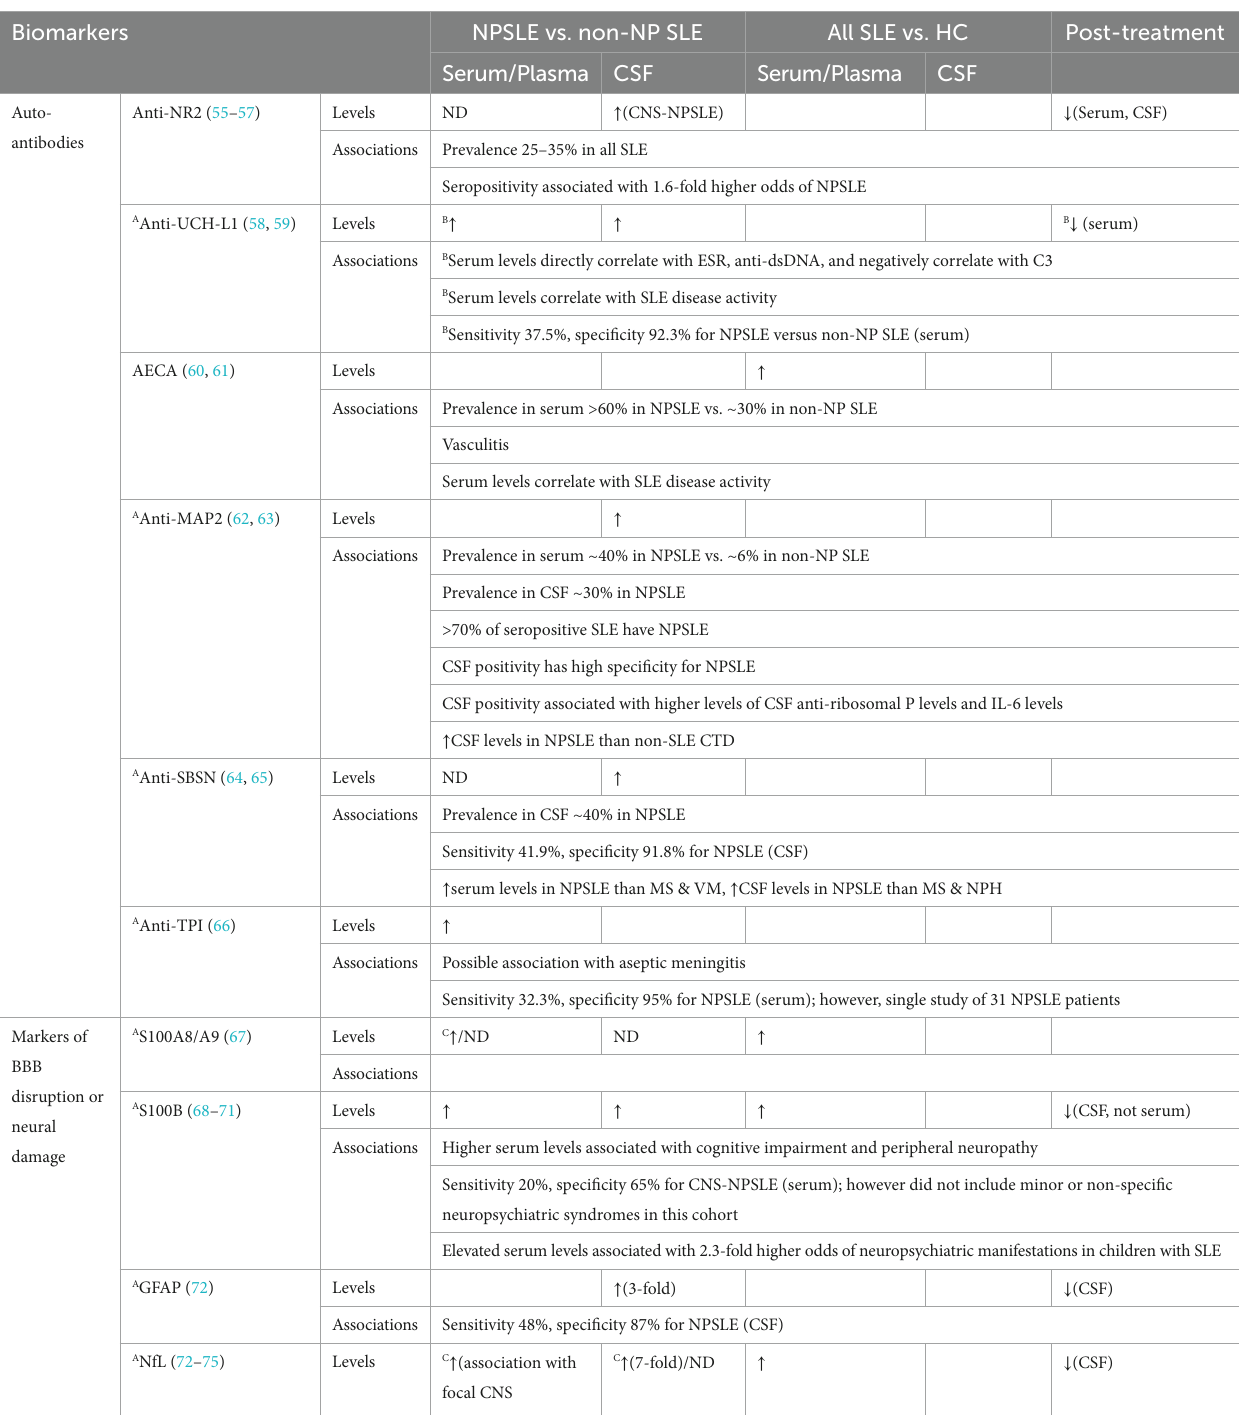
TABLE 2 Novel biomarkers for NPSLE. Biomarkers NPSLE vs. non-NP SLE All SLE vs.